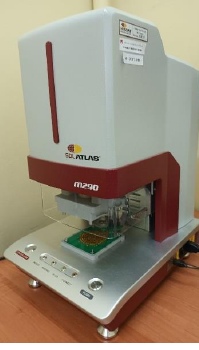
Figure 1. The Moisture Management Tester M 290 by SDL Atlas.